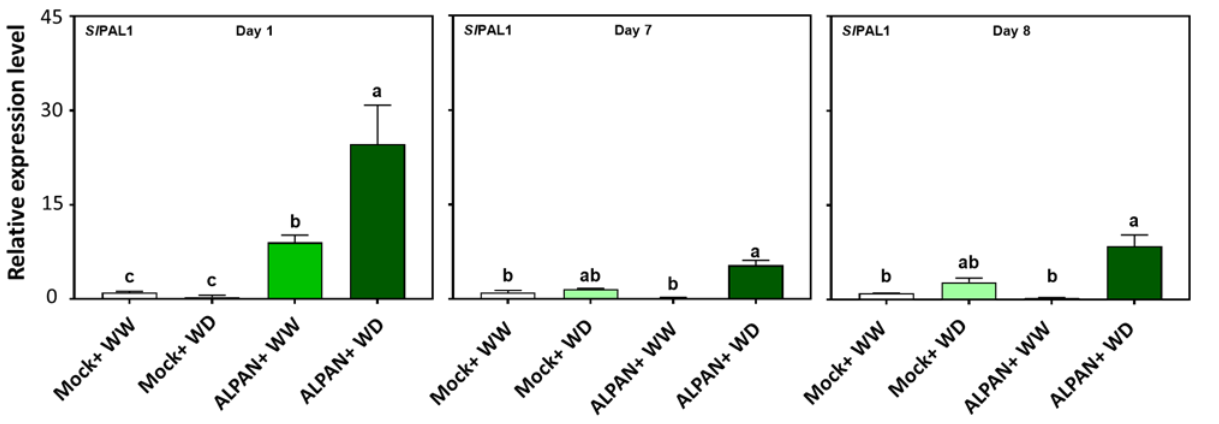
Figure 10. Expression levels of SlPAL1 after 1, 7, and 8 days of the initiation of the stress. WW = well watered, WD = water deficit. Error bars above histogram columns represent the standard deviation of four independent biological replicates in each experimental group at each sampling timepoint. The statistical data were analyzed with the use of the one-way ANOVA and Tukey’s post hoc tests, and a statistically significant difference ( p -value < 0.05) is denoted by a different letter above a histogram column.